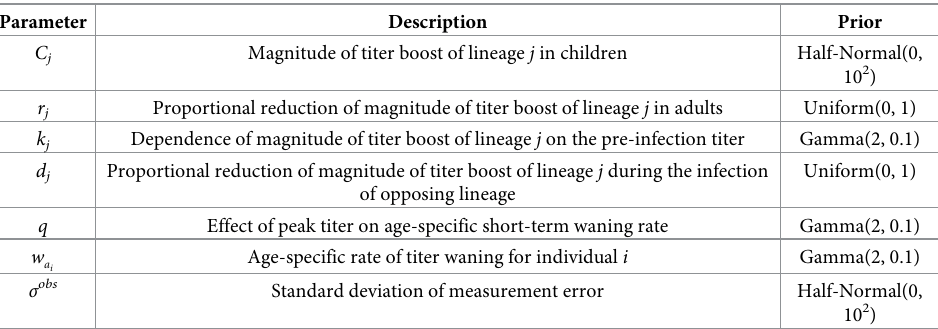
Table 1. Description of model